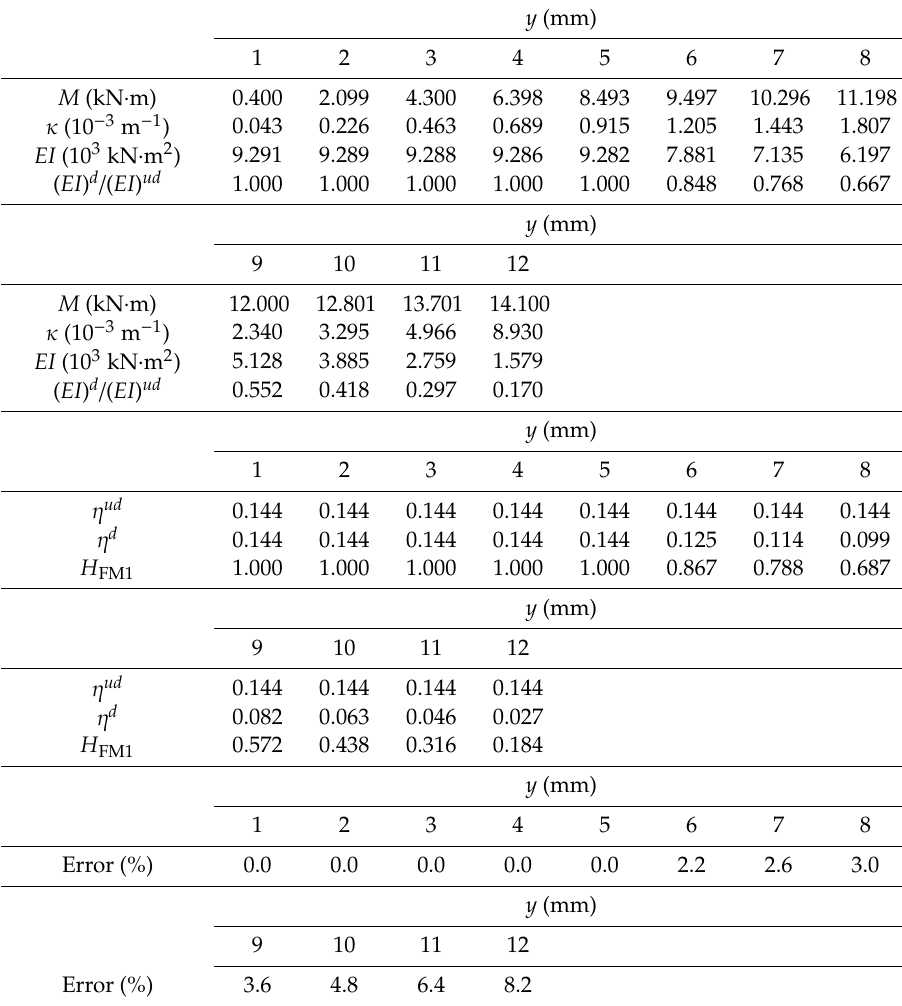
Table 17. Comparison between ( EI ) d / ( EI ) ud and H FM1 in E10.